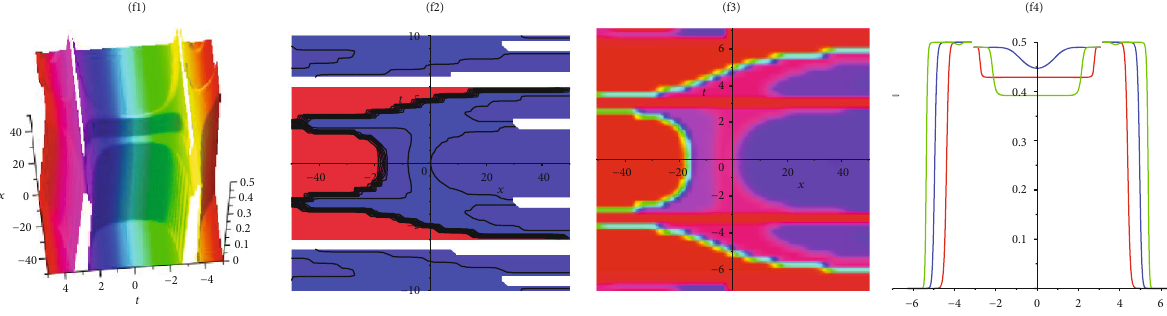
Figure 14: The two-wave solution (67) at α = 0 : 5, β = 0 : 2, α h ð t Þ = cos ð t Þ , and y = 1 .